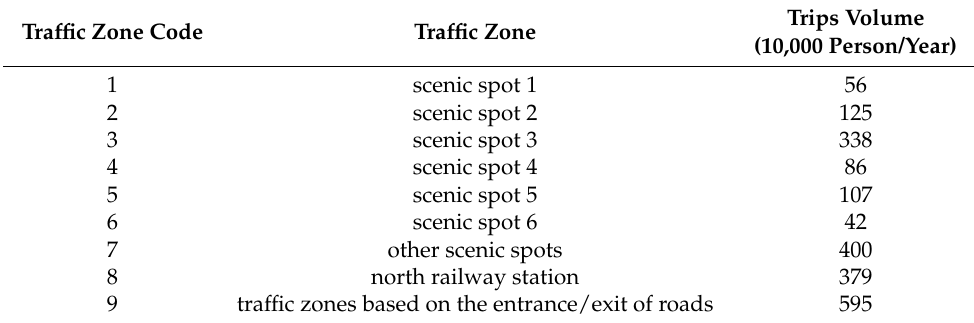
Table 1. Distributing volume of each traffic zone.